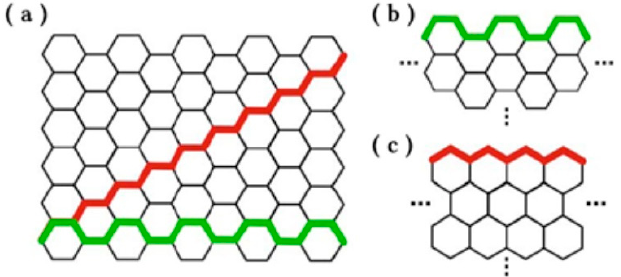
Figure 46. ( a ) Structure of graphene nanoribbon: ( b ) armchair, ( c ) zigzag.